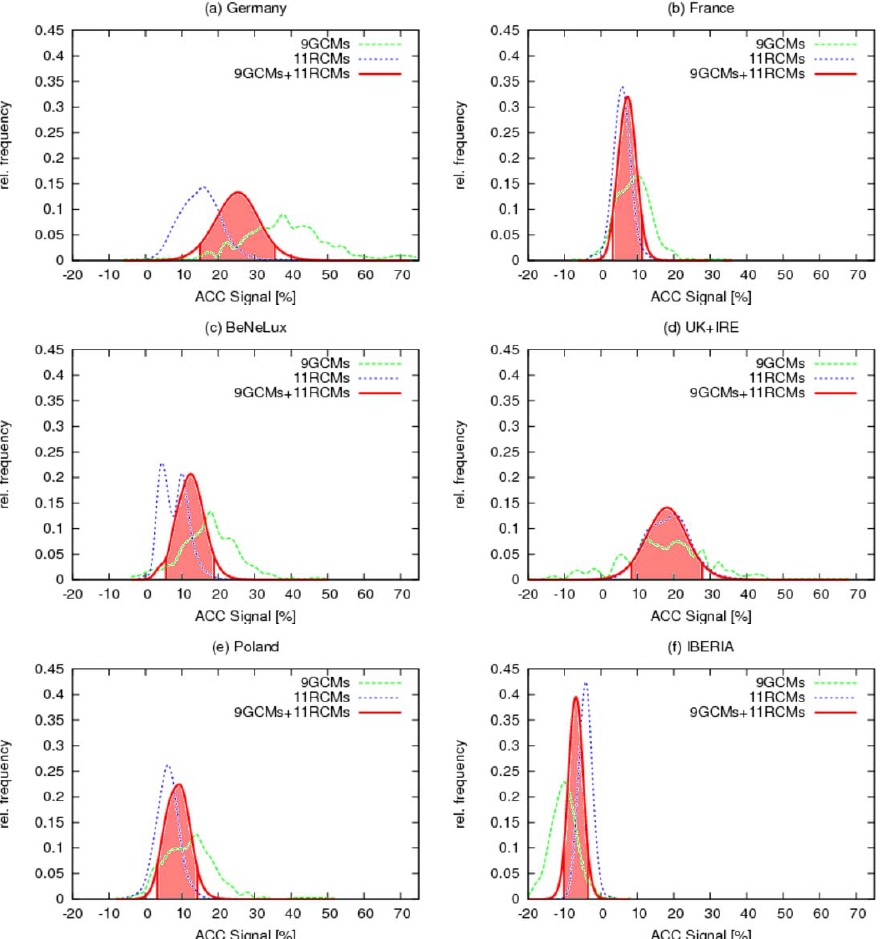
Fig. 7: Probability of loss potential changes for the future climate period end of 21C (2071–2100) compared to 20C (1961–2000) without adaptation of the loss threshold, based on all the possible model combinations of GCMs (green curve), RCMs (blue curve) and all available GCM and RCM scenarios (red curve) simulations. The red shaded areas mark the range where 90% of the change signals (between 5th and 95th percentile) based on all model combinations are found .